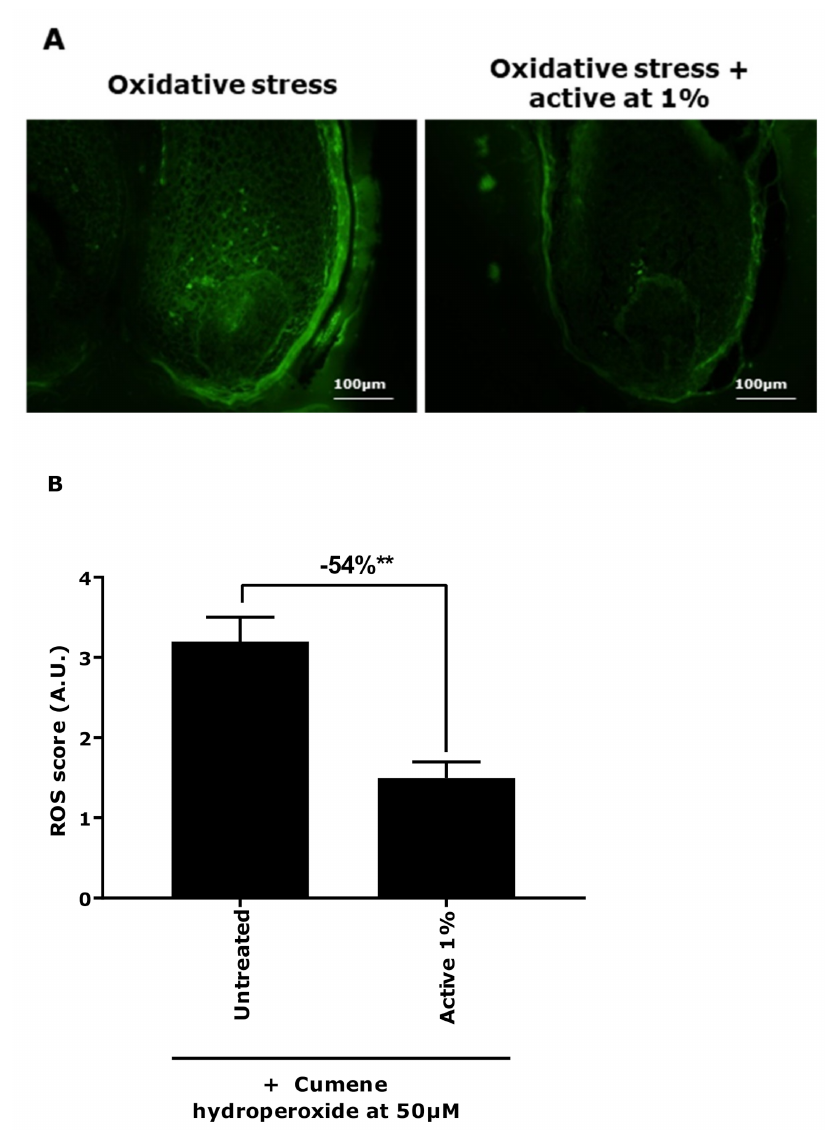
Figure 5. ROS production assessment in hair follicles in a canities-induced condition (cumene hydroperoxide at 50 µ m) in the presence of active ingredient at 1%. ( A ) Representative images. Magnification: 20 × . ( B ) Quantification of the mean fluorescence intensity ( ± SEM) of DCFH-DA probe. Statistical analysis was performed using one-way ANOVA with permutation test followed by Tukey’s test, with ** p <